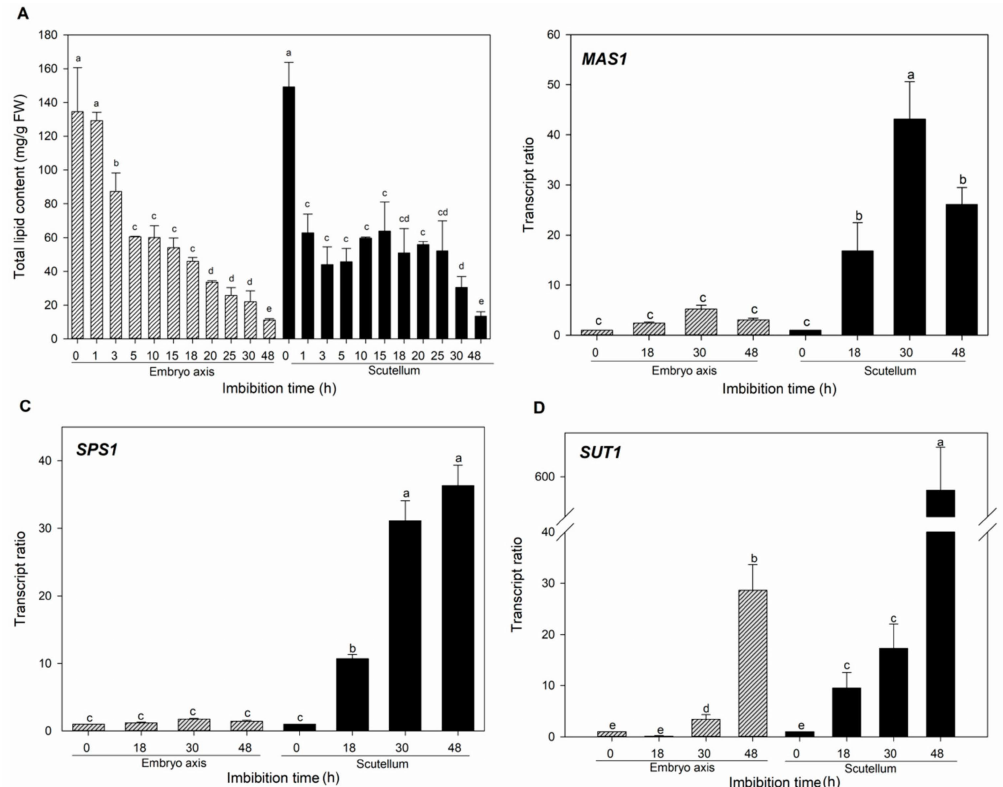
Figure 3. Lipid content ( A ) and RT-qPCR relative transcript amount of MAS ( B ), SPS ( C ), and SUT1 ( D ) in the embryo axis and scutellum at di ff erent imbibition times. Bars represent the average of triplicates of two independent experiments ± SD. Ratio transcript was calculated according to the Pfa ffl method [30], normalizing with the invariant housekeeping gene 18s and also with the value of the mRNA amount found in the tissues from non-germinated seeds (0 h). Di ff erent letters indicate statistically significant values according to the Tukey test, p <